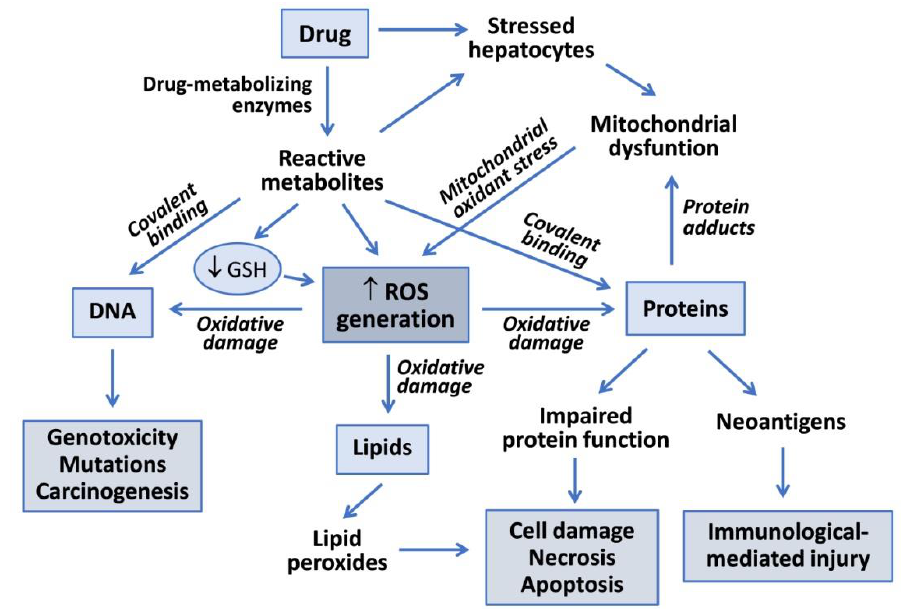
Figure 1. Mechanisms of drug-induced hepatotoxicity. Drug metabolism can render reactive metabolites that are able to induce hepatotoxicity via covalent binding to macromolecules or via oxidative damage induced by increased reactive oxygen species (ROS) generation. Reactive metabolites can interact with DNA to produce genotoxicity, induce lipid peroxidation or form adducts with proteins, which can lead to functional impairment, cell death or to the generation of neoantigens that trigger immune-based toxicity. Mitochondrial dysfunction induced by drugs, or more frequently by their reactive metabolites, contributes to increased ROS formation and oxidative damage to liver cells.